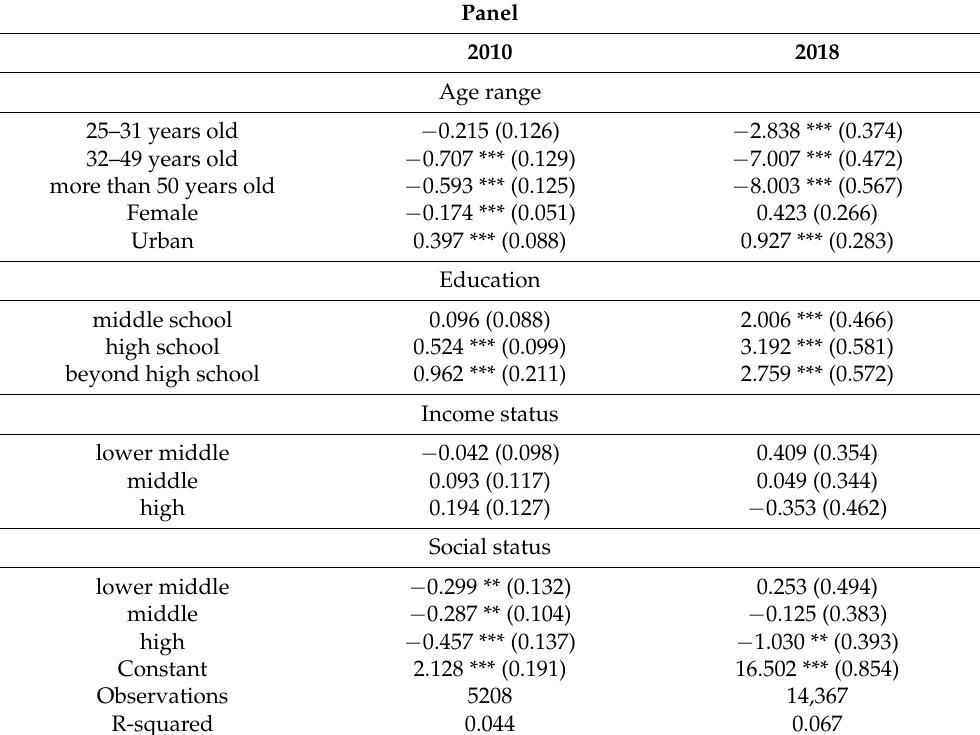
Table 2. Results of the multiple regression model predicting the frequency of internet use in the 2010 and 2018